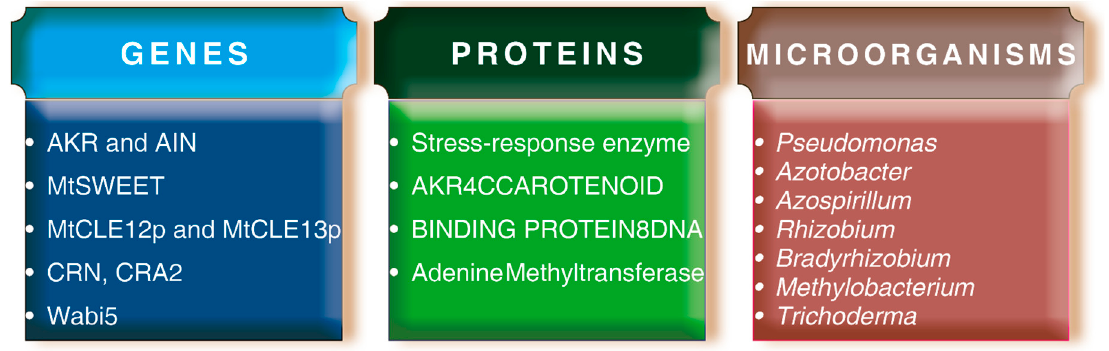
Figure 1. Elements involved in fitness and molecular and genetic improvement of the crop